Question: In a single sentence, describe what this figure presents.
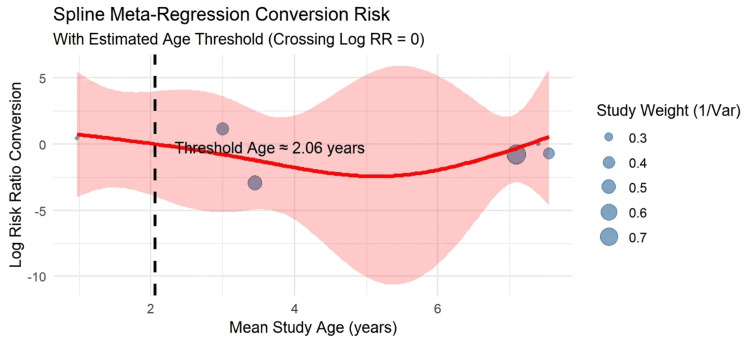
Answer: Bubble plot spline meta-regression. Bubble plot with restricted cubic spline regression illustrates the relationship between mean patient age and the risk of conversion (Log Risk Ratio). The vertical dashed line suggests an estimated inflection point at 2.06 years, suggesting a potential change in the risk profile associated with limited retroperitoneal working space in younger infants.